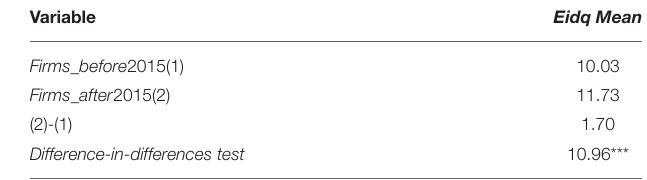
TABLE 10 | Influence mechanism test.